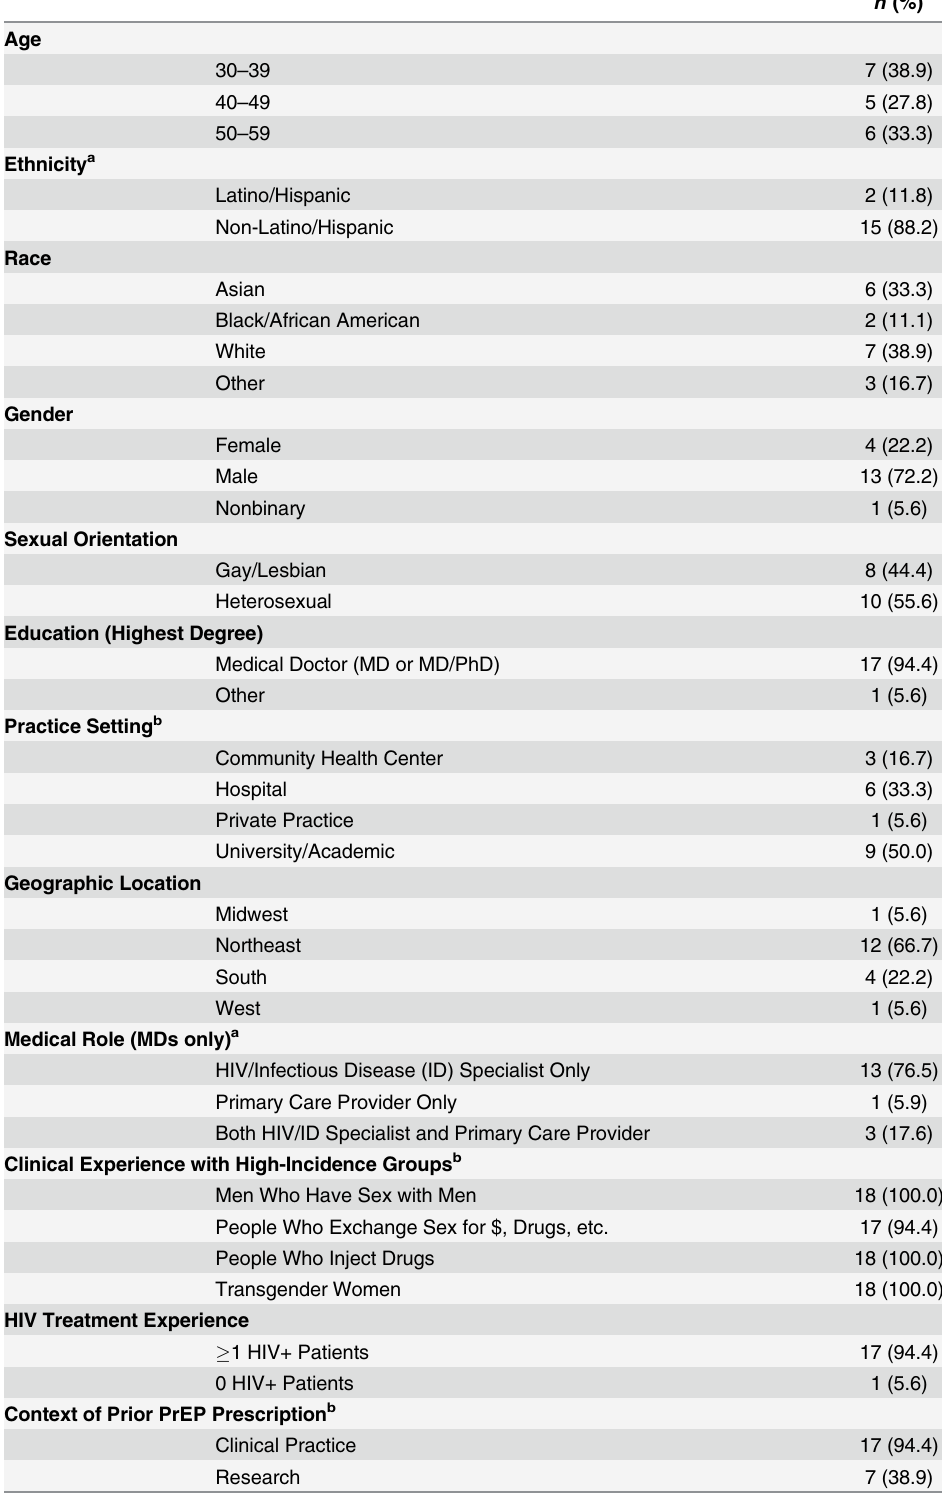
Table 1. Characteristics of Early-Adopting PrEP Provider Sample ( n =